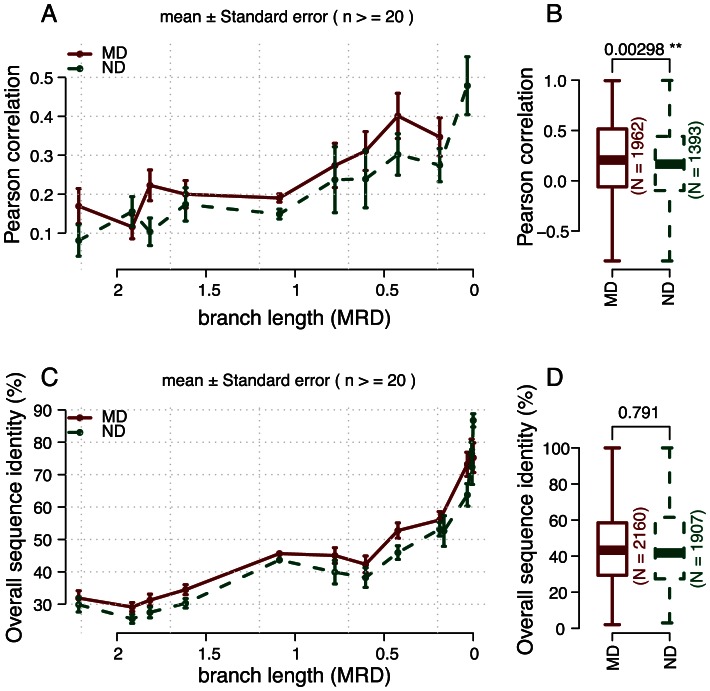
Evidence for functional redundancy in duplicated disease genes.Comparing with duplicated non-disease genes (ND) of similar duplication age (represented by branch length, see Methods), monogenic disease genes (MD) tend have A) higher co-expression co-efficient (p-value = 1.69×10−3, Hypergeometric Distribution test), C) higher sequence similarity (p-value = 1.66×10−3, Hypergeometric Distribution test). Results in A) can be repeated using another set of gene expression data (Figure S3). P-values shown in the boxplots (B and D) were calculated using two-sample Wilcoxon Rank Sum Test; see Materials and Methods for more details regarding the statistical tests. Numbers shown next the boxplots are the numbers of valid samples (after removing samples with missing values).